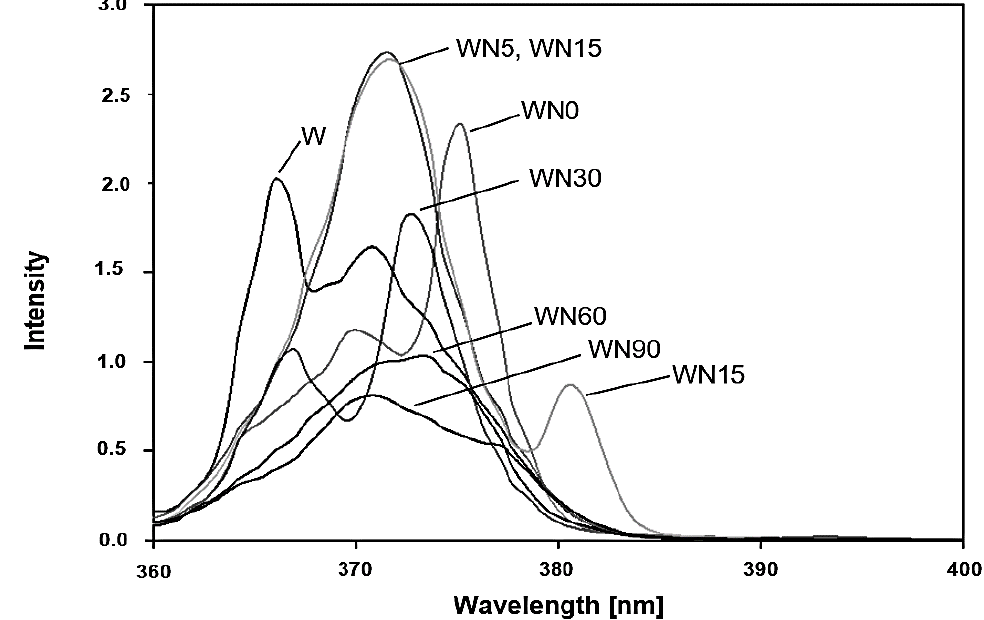
Figure 4. Raman spectra of deionized water stored in contact with the air (W) and saturated with nitrogen prior (WN0) and after treating with GP for 5 to 90 min (WN5-WN90), respectively.